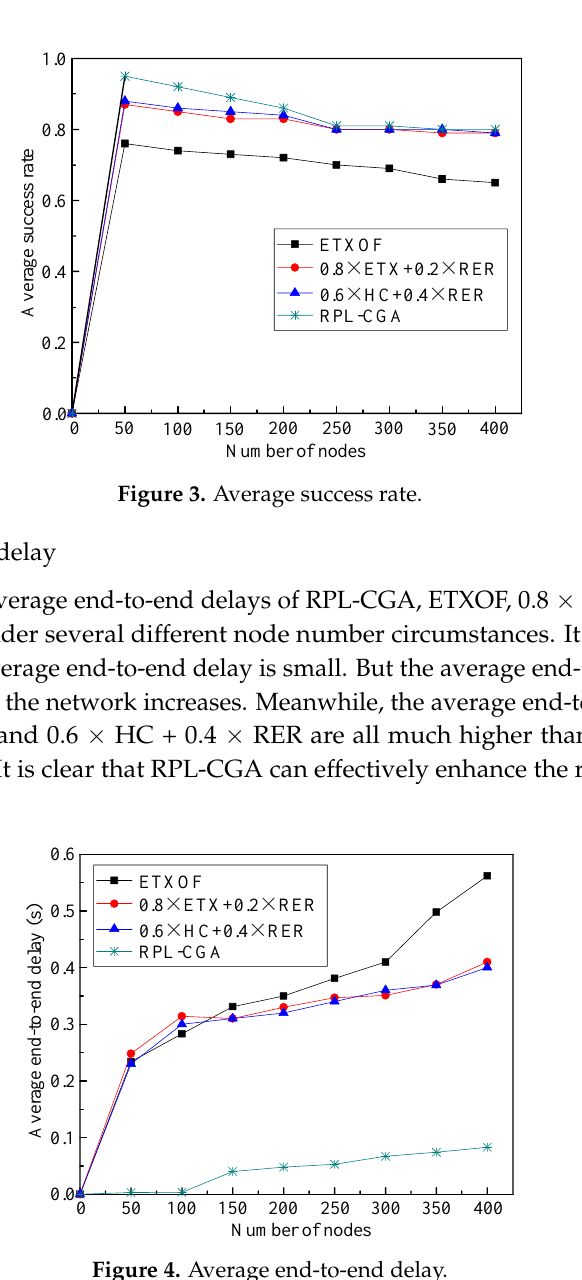
Figure 4. Average end-to-end delay.